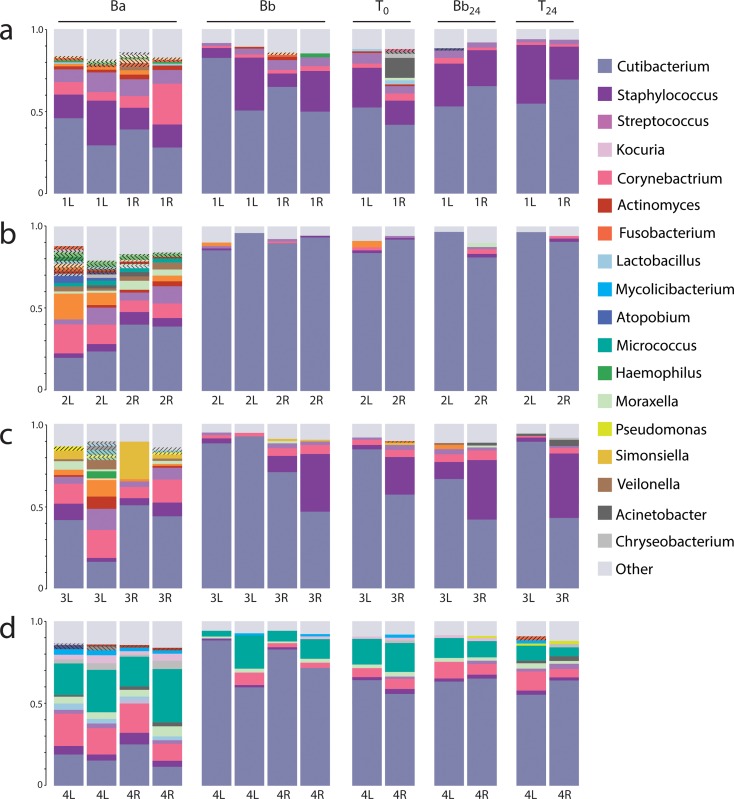
Relative readcount by genus (% of classified reads).(a) Subject 1, (b) Subject 2, (c) Subject 3, (d) Subject 4. While the differences between the baseline arm [Ba] and back [Bb] are striking at this resolution, evidence of successful movement of arm bacteria is more difficult to discern in the samples of recipient sites [T0, T24]. The 18 most common genera (>3% total reads in a sample) are labelled with a corresponding color. Genera with between 1% and 3% total reads have their own color but are not labelled in the key; these species are marked with diagonal lines to distinguish them from those in the color key. Genera with <1% are grouped in “other”. On average, 96% of reads were classified in each sample (range: 91% - 100%).